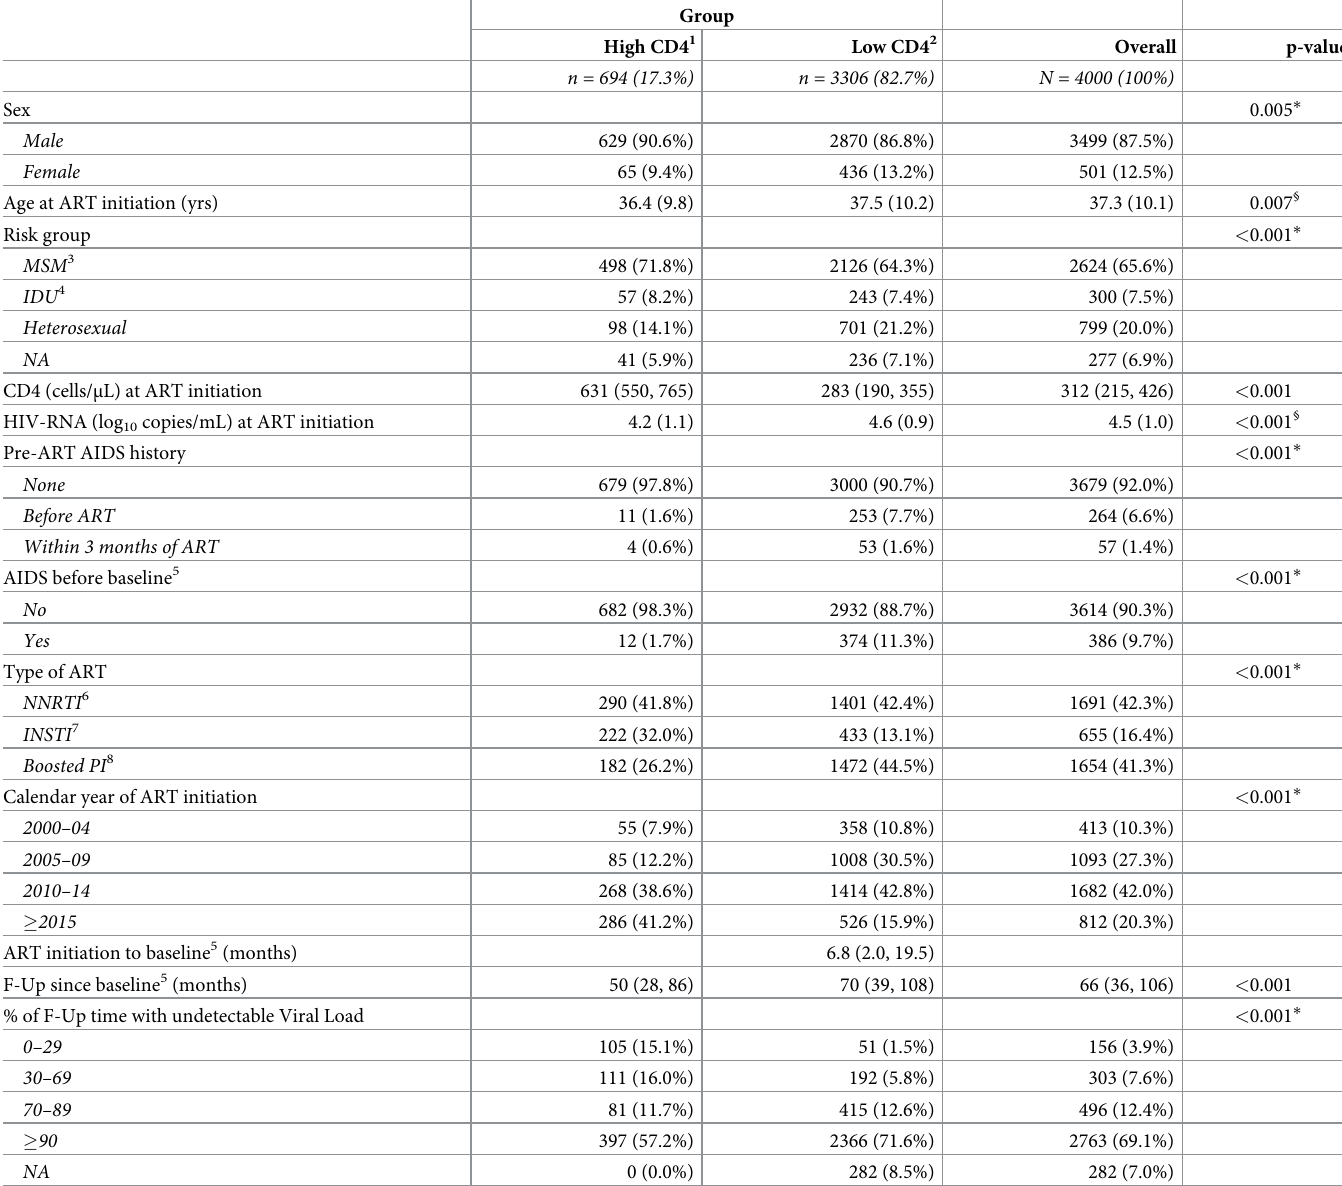
Table 1. Demographic and clinical characteristics by CD4 at ART initiation and overall. Figures are n (%), Mean (SD) or Median